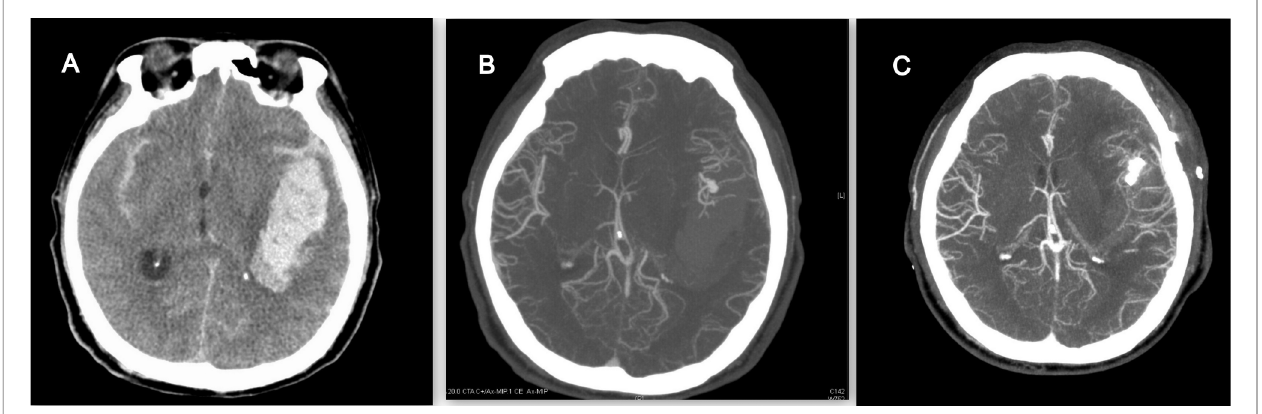
FIGURE 4 | 55-year-old female with ruptured left MCA aneurysm. ( A ) Large left temporal hematoma, but no perisylvian low density, no spot sign, no distal hematoma. ( B ) CTA revealed M1 bifurcation aneurysm. ( C ) After successful clipping, there were no delayed progressive mass effect 7 days after operation.